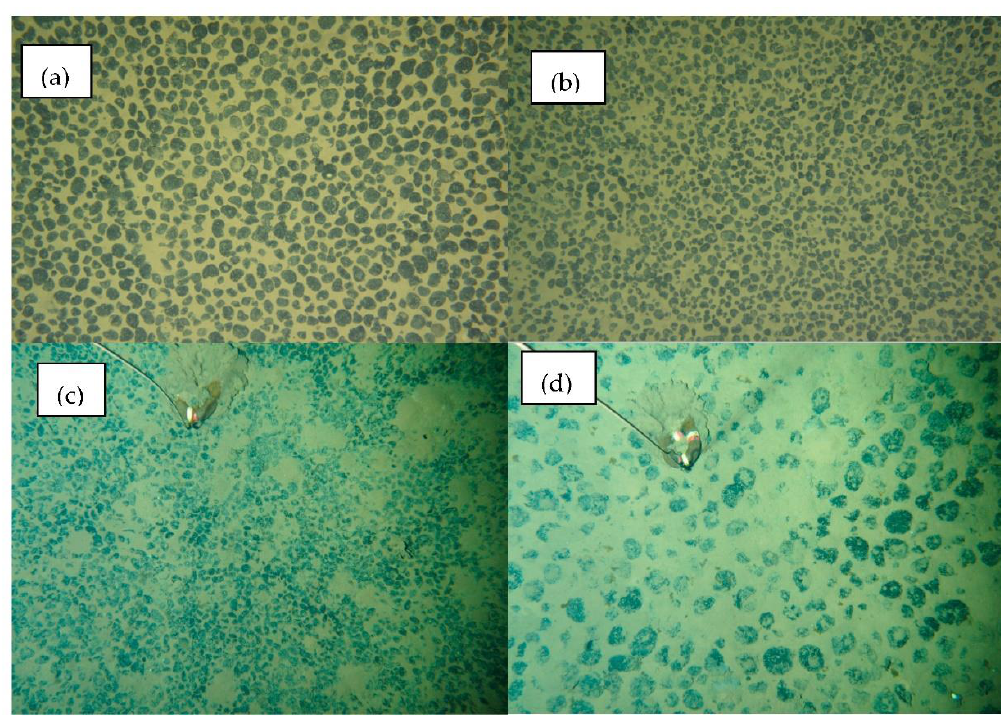
Figure 14. Seabed photos from TOML B, C and F. ( a ) TOML B, CCZ15-F02: 2015_08_17_032745 ( b ) F05: 2015_08_29_071000 ( c ) TOML F type 1 nodules CCZ15-B105 ( d ) TOML F type 2 nodules CCZ15- B99. Images in ( a ) and ( b ) are 2.4 m × 1.6 m in area. Trigger weight in images ( c ) and ( d ) is 28 × 16 cm long.